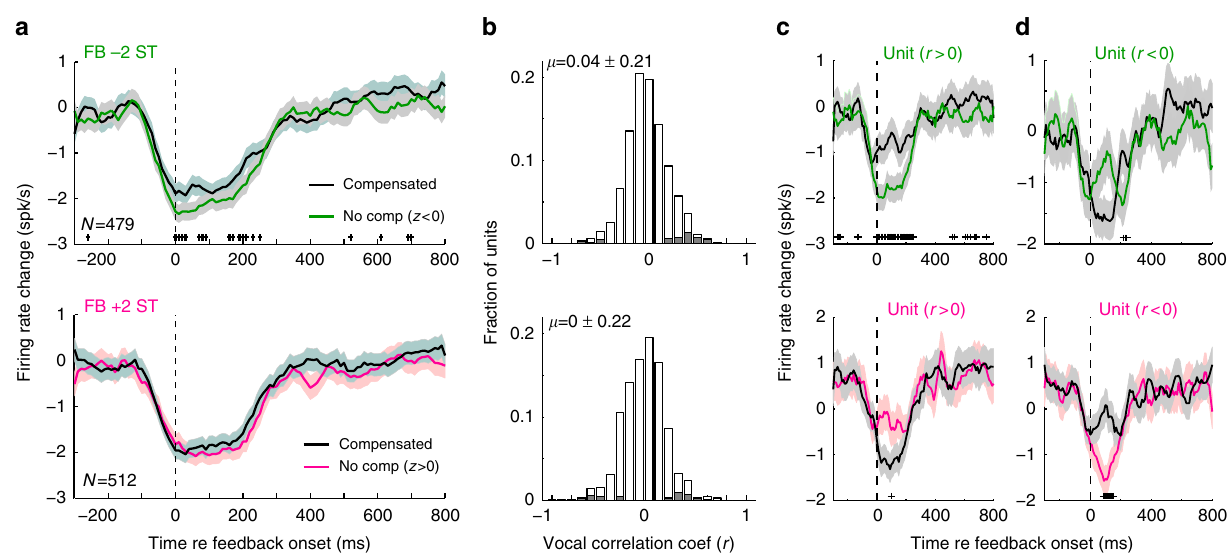
Fig. 4 Populations responses preceding vocal compensation. a Population average PSTHs showing differences between compensated and non- compensation trials for FB − 2ST (top) and + 2ST (bottom) in suppressed units (RMI ≤ − 0.2). Number of units are indicated (Error bars: SEM; + p < 0.05, Kruskall – Wallis). b Population distribution of individual unit vocal correlation coef fi cients showing variability between units (Shaded: p < 0.05). Mean± std (standard deviation) indicated. c , d , Population PSTHs after splitting units between those with vocal correlation coef fi cients r > 0 ( c ) and r < 0 ( d ). PSTHs show differential activity starting after the onset of altered feedback. Differences were noted to be stronger for units whose correlation coef fi cients predicted the expected behavioral compensation (bolded) during altered feedback: r > 0 for FB − 2ST ( c , top) and r < 0 for + 2ST ( d , bottom), as evidenced by the presence of signi fi cantly different time bins ( p < 0.05; − 2ST: 23 signi fi cant time bins in the 250 ms for r > 0 vs. 3 in r < 0; + 2ST: 7 bins for r < 0 vs. 1 for r > 0). Sample sizes and statistical details may be found in the Supplementary Note 1 Table 1 Number of units with signi fi cant vocal correlations